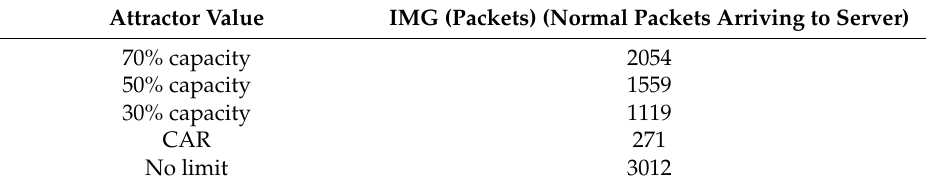
Table 5. Packets arriving to server statistics for the experiment in different